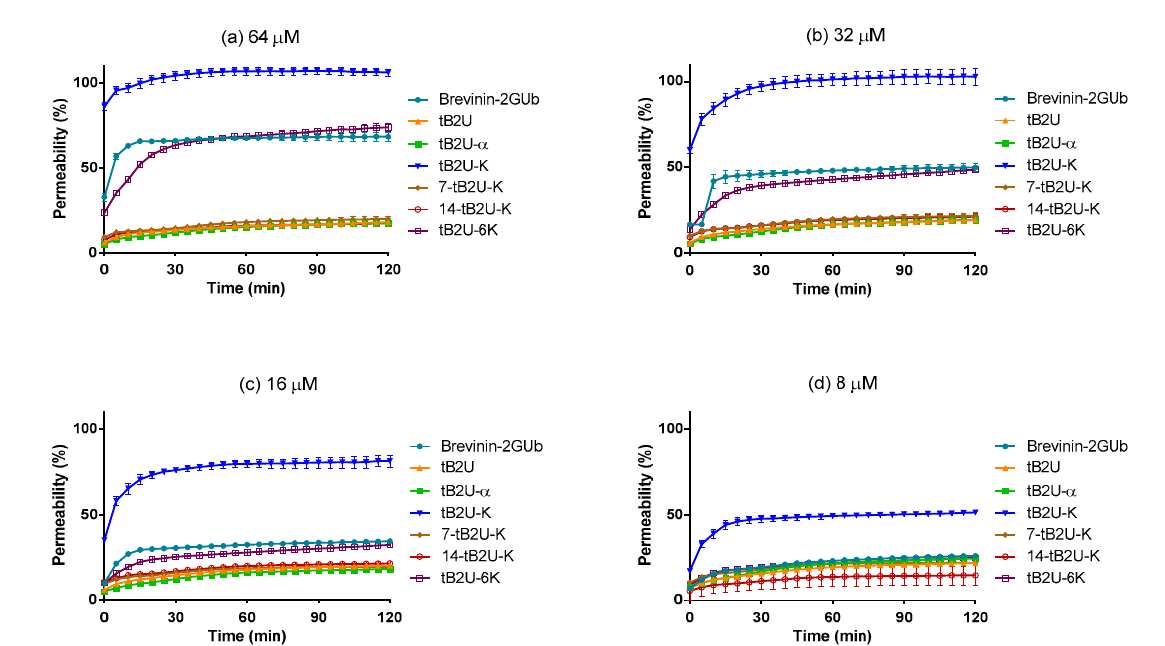
Figure 7. The membrane permeability curves against S. aureus of Brevinin-2GUb and its analogues at the concentration of ( a ) 64 µM, ( b ) 32 µM, ( c ) 16 µM and ( d ) 8 µM. The error bar represents the SEM of the five replicates.